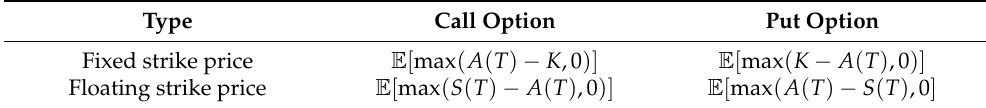
Table 1. Maturity returns of arithmetic average Asian options.